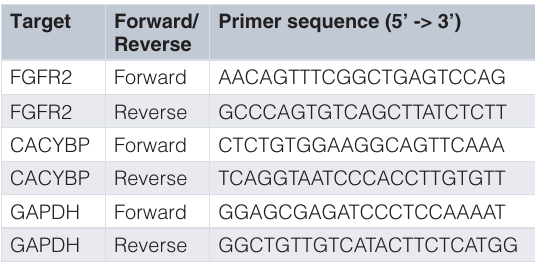
Table 3. Primers and Targets.